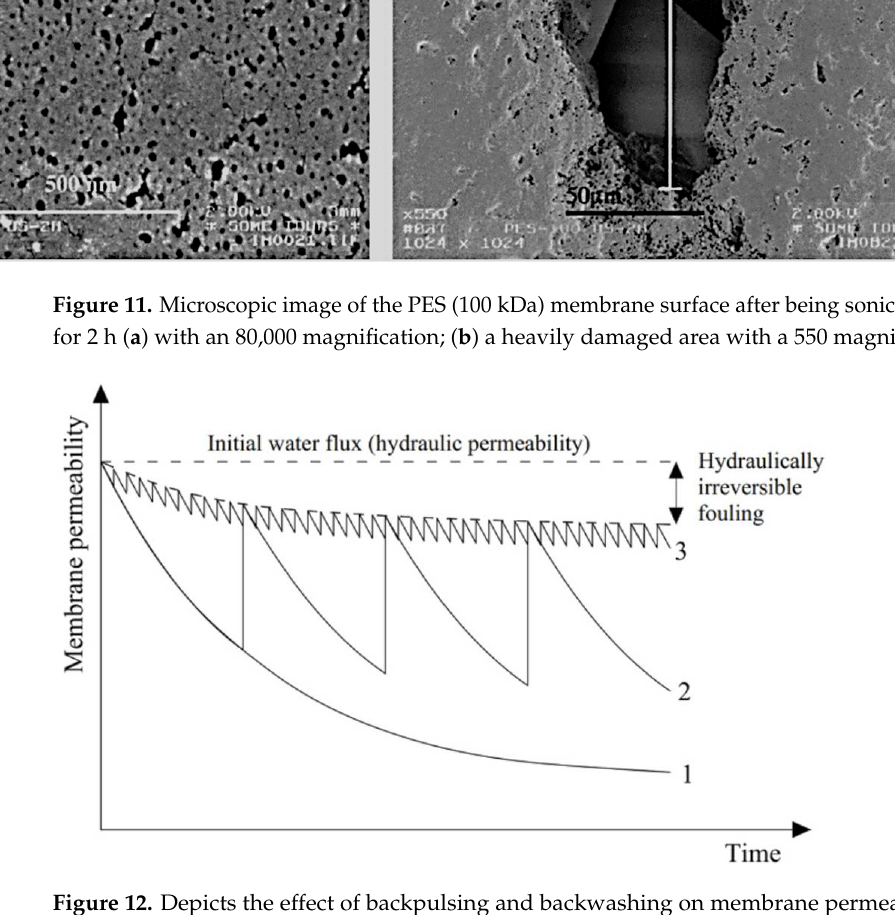
Figure 11. Microscopic image of the PES (100 kDa) membrane surface after being sonicated at 47 kHz for 2 h ( a ) with an 80,000 magnification; ( b ) a heavily damaged area with a 550 magnification [88].